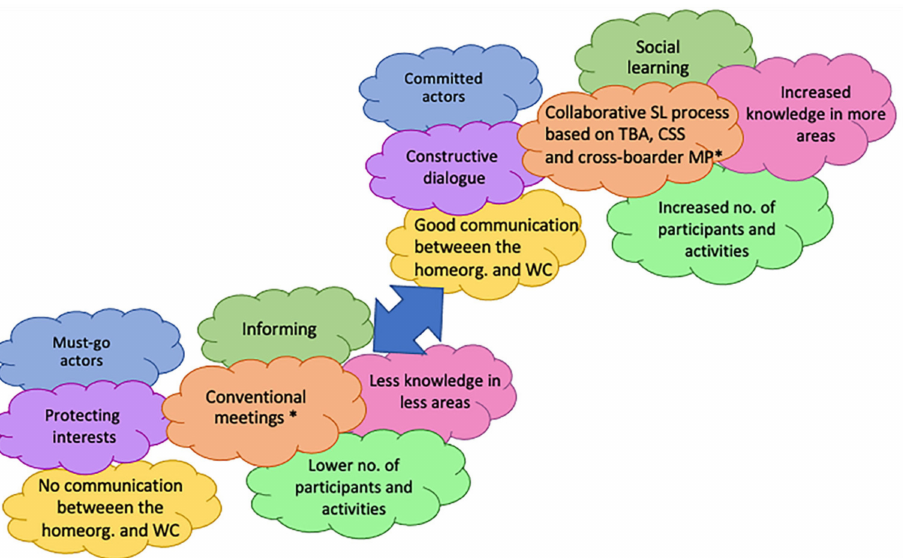
Figure 5. Process characteristics changing through facilitation and other factors promoting SL. Source: Based on own data. *